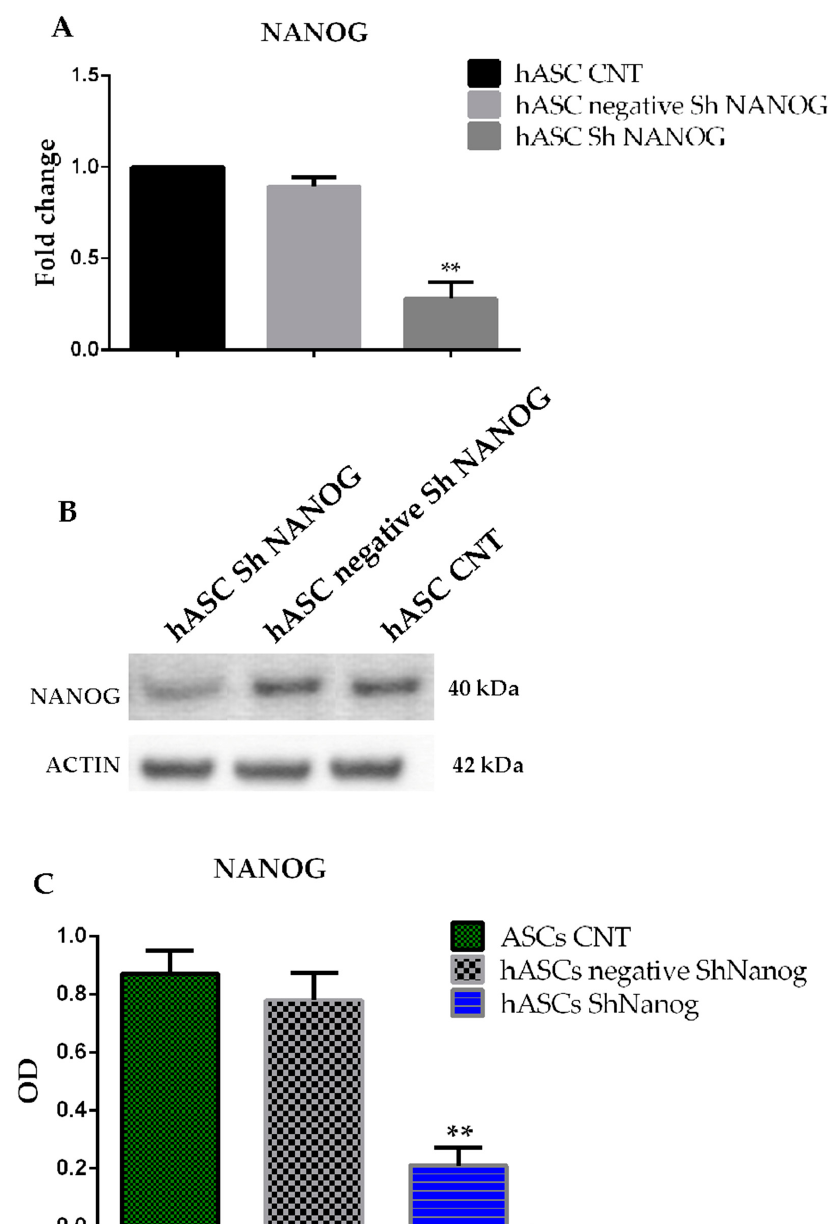
Figure 2. Freshly isolated hASCs at passage 4 (hASCs CNT), hASCs lentivirally transducted with scrambled (negative) or shRNA against NANOG . ( A ) qRT-PCR analysis for NANOG gene expression after 10-day antibiotic selection. Relative expression levels were assessed using the 2 − ∆∆ C t method. Data are representative of three independent experiments with the fold change compared to expression levels in a commercial human adipose stem cell line (ASC52telo, hTERT immortalized adipose-derived mesenchymal stem cells). Values are shown as the mean ± SE, ** p < 0.01. ( B , C ) Western blot analysis for protein expression of NANOG after 15 days of antibiotic selection. Values are shown as mean ± SE, ** p < 0.01.